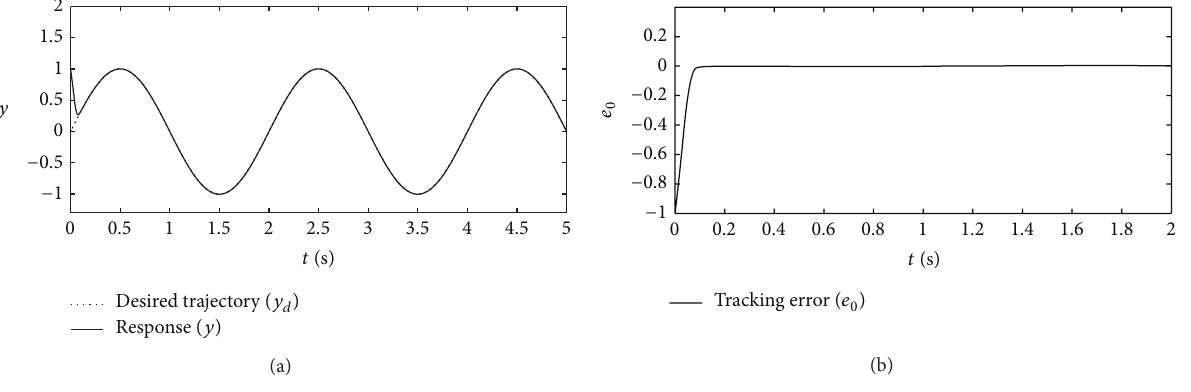
Figure 6: Chaos suppression and speed tracking of the controlled PMSM.